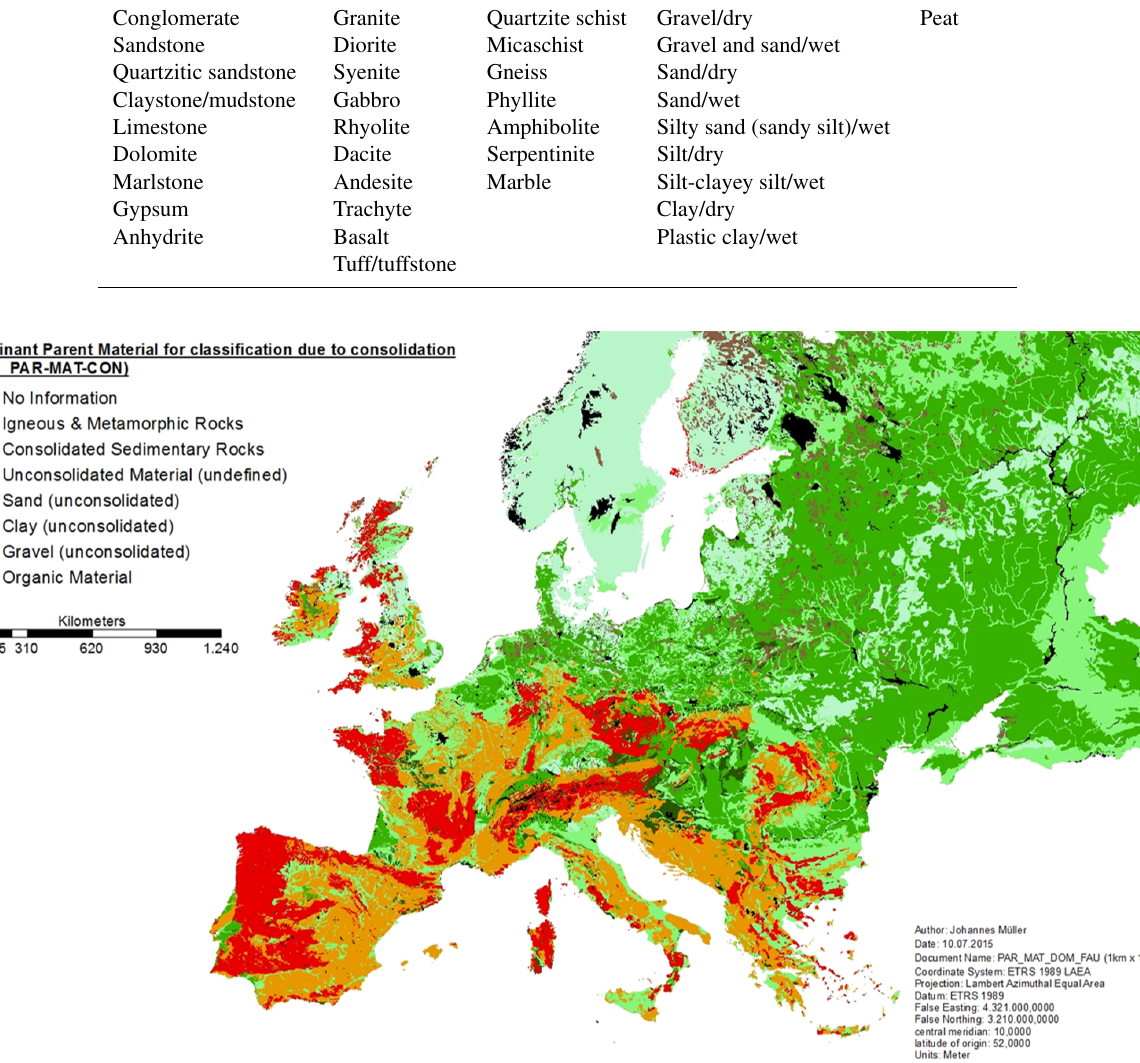
spite these being located at different altitudes. The lapse rate method uses the temperature values of the nearest weather station and the difference in elevation to estimate the temper- ature at the un-sampled site. The estimation is based on the nearest known temperature, the elevation difference between the two points and a specified temperature gradient calcu- lated every month by identifying pairs of low-elevation, high- elevation stations close to the interested point and computing vertical temperature gradients. The method and the proposed database are properly described in De Carli et al.